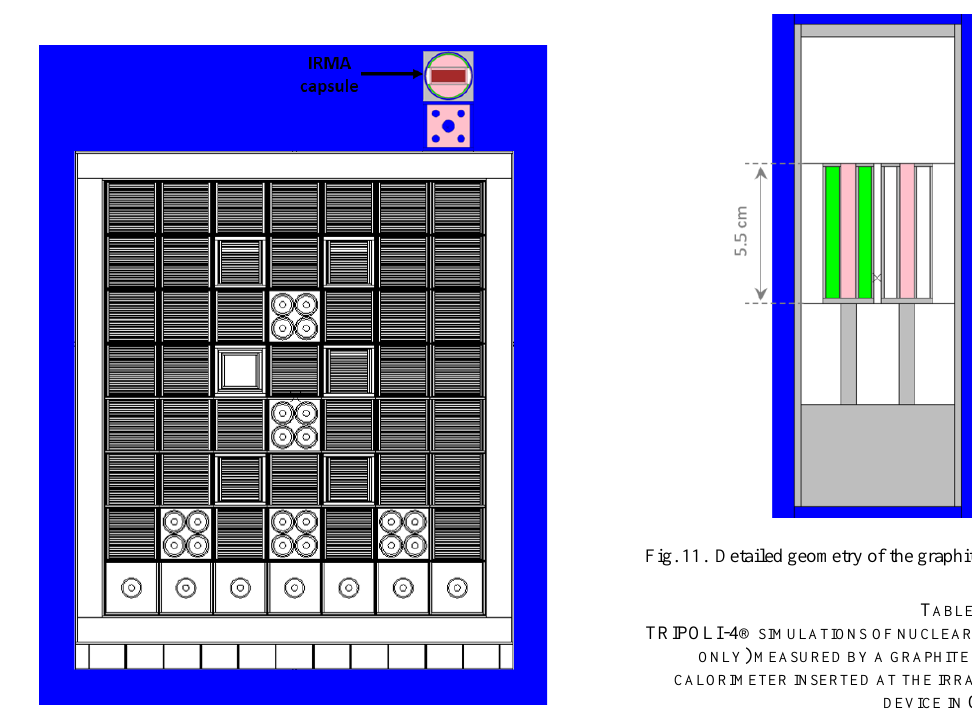
Fig. 9. Radial layout of the OSIRIS reactor core modelling with TRIPOLI-4®